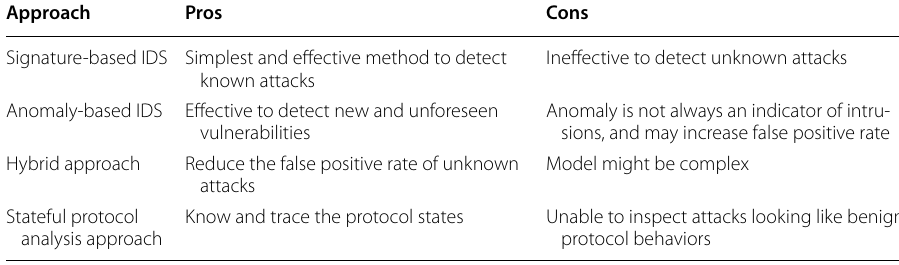
Table 1 Various types of intrusion detection approaches